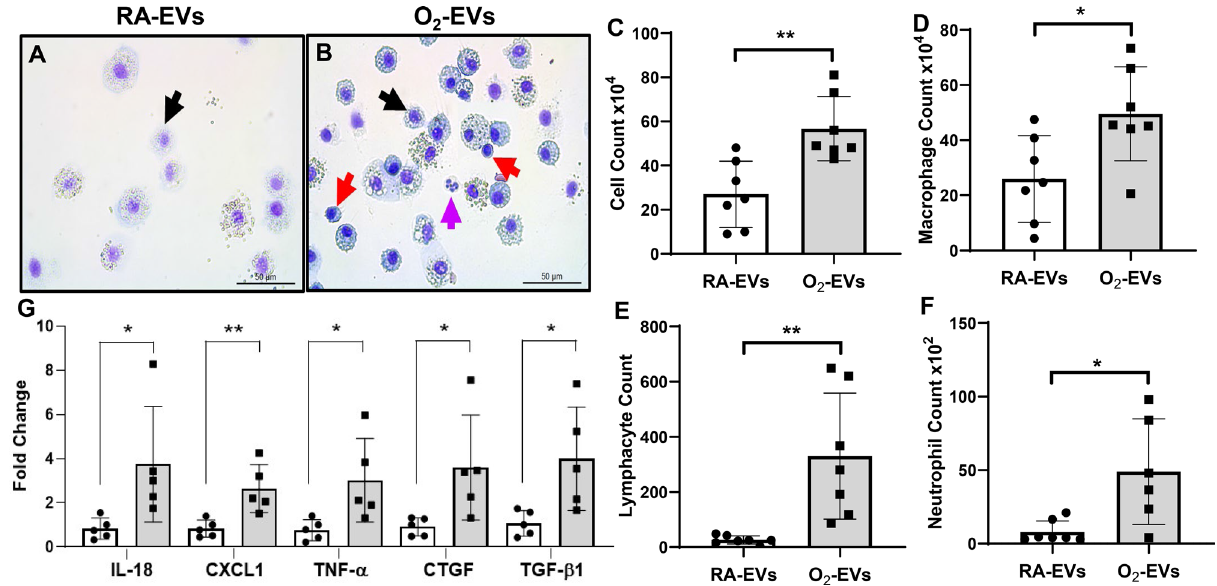
Figure 3. Circulating EVs from hyperoxia-exposed rats induce lung inflammation when adoptively transferred into normal neonatal rats. RA-EVs and O 2 -EVs were injected into normal neonatal rats via temple vein on P3 and tail vein on P7. Representative cytospins of bronchoalveolar lavage fluids (BALF) from RA-EVs injected ( A ) and O 2 -EVs injected ( B ) rats. The total cell count (( C ), ** P < 0.01), macrophage count (( D ), black arrow, * P < 0.05), lymphocyte count (( E ), red arrow, ** P < 0.01) and neutrophil count (( F ), purple arrow, * P < 0.05) were increased in O 2 -EVs injected rats. n = 7/group. ( G ) qRT-PCR demonstrated that lung tissues from O 2 -EVs injected rats have increased gene expression of IL-18, CXCL1, TNF-α, CTGF and TGF-β compared to RA-EVs injected rats (n = 5/group, * P < 0.05 and ** P <